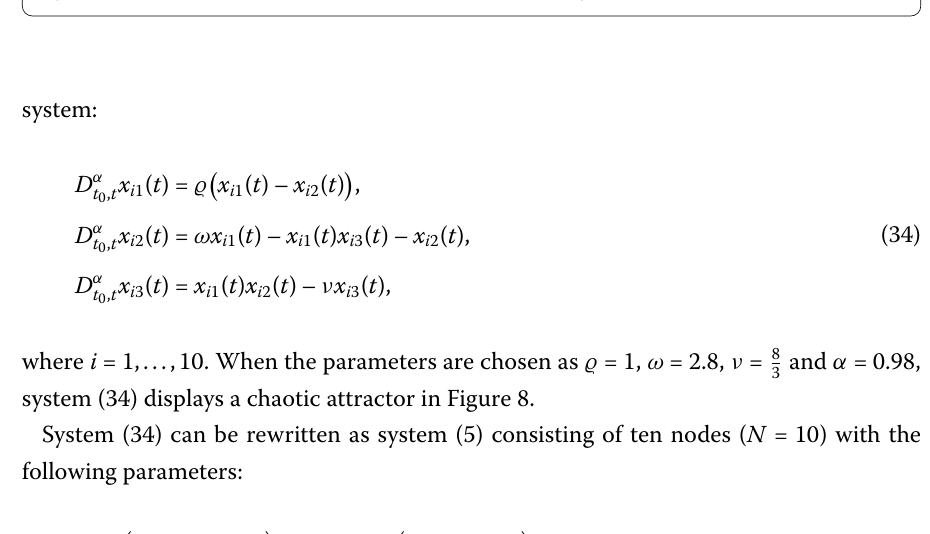
Figure 8 Chaotic attractor of a fractional-order chaotic Lorenz system with order α =